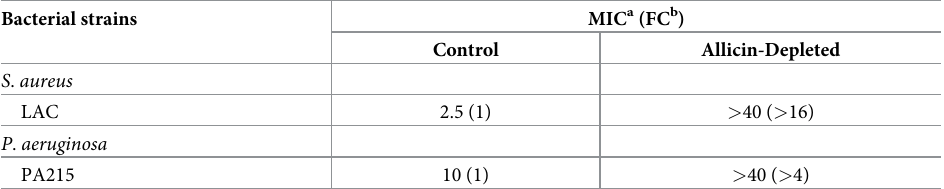
Table 4. Effect of allicin depletion on susceptibility of multi-drug resistant bacterial strains to ES-GBBr formula- tion SM-NP fraction.